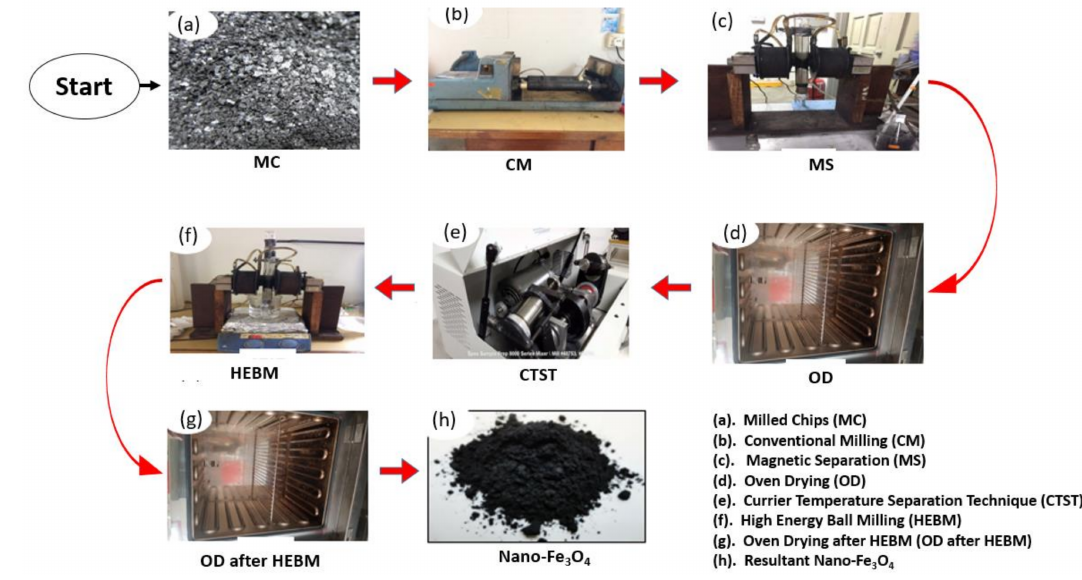
Figure 1. Procedure for the synthesis of magnetite nanoparticles (Fe 3 O 4